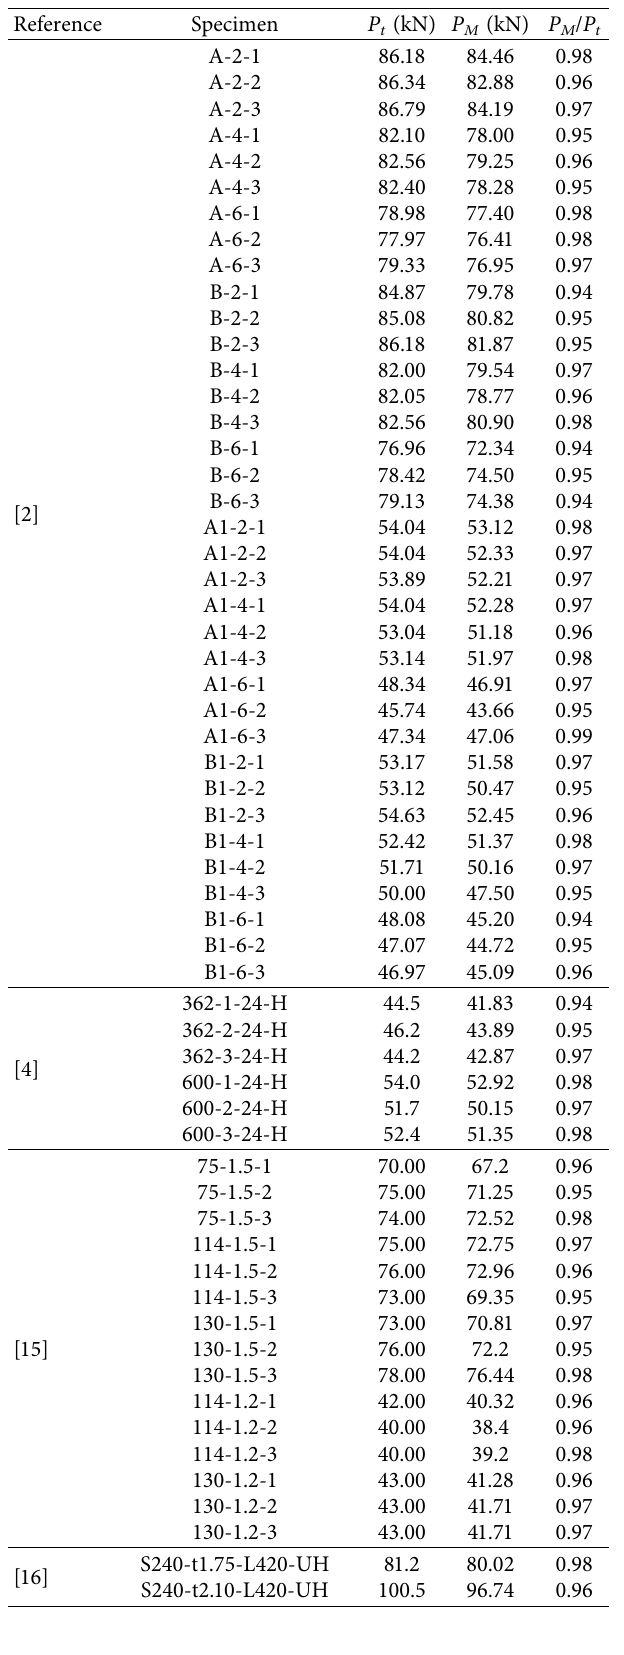
Table 6: Comparison of ultimate strengths between tests in [2], [4], and [15] and calculated results using the proposed EWM. Reference